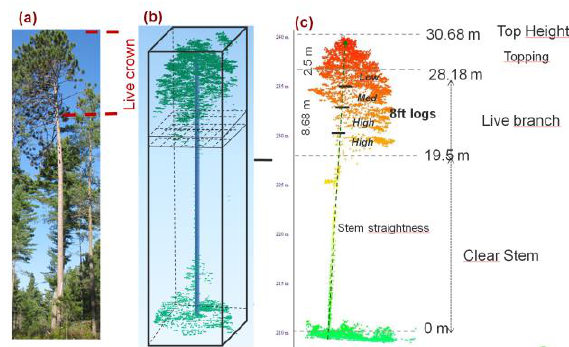
Figure 3. A sample of the estimation of wood quality determinants of individual white pine tree (a) tree in the field (b) its lidar point distribution and voxelisation (c) extracted quality